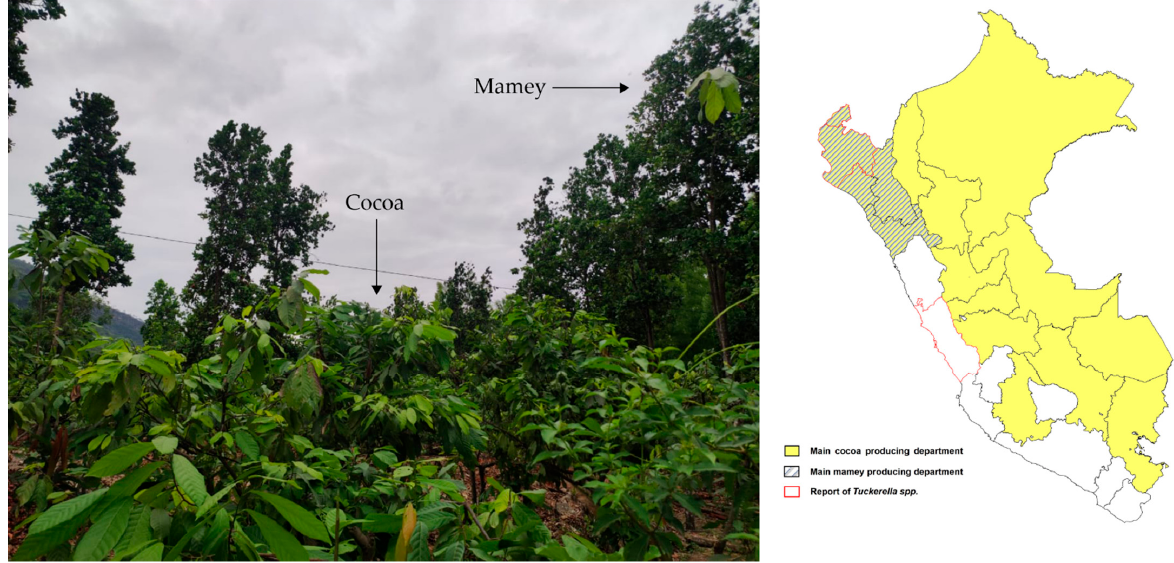
Figure 3. Current Tuckerella spp. distribution in Perú on mamey and cocoa crops.